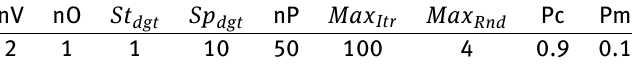
Table 31: VSSCGA Settings for Schaffer 4 function (for precise value finding)